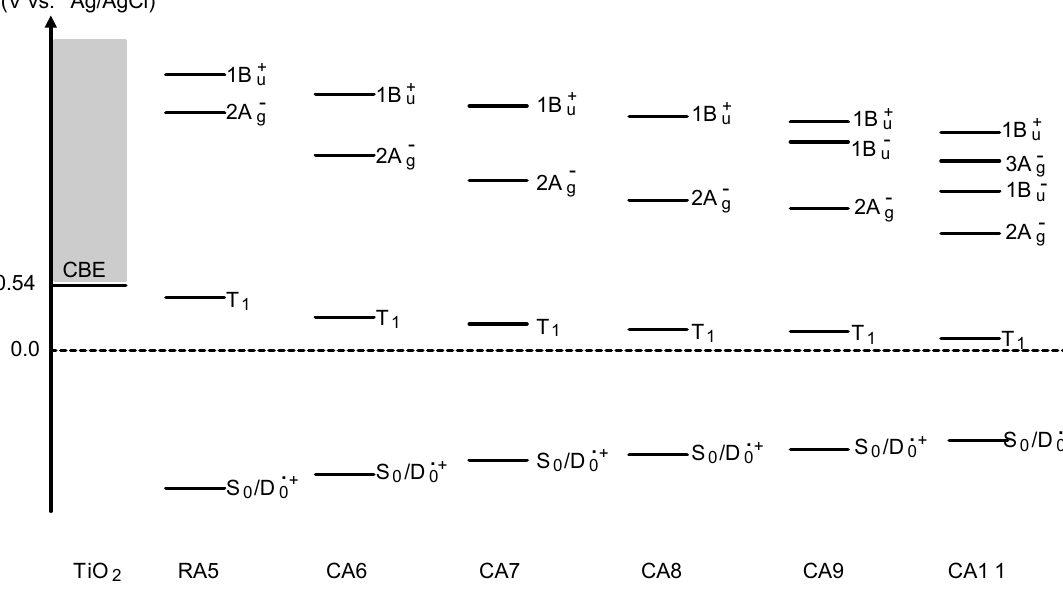
(reprinted from [4] with 2